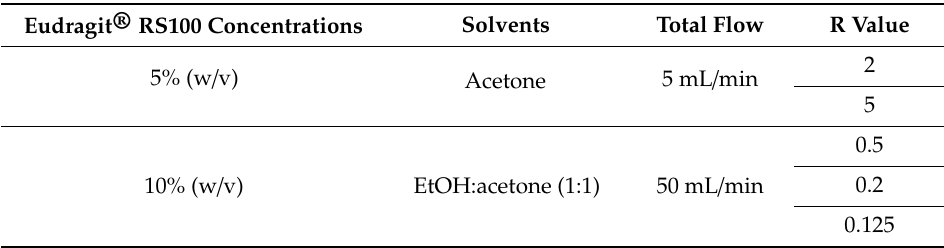
Table 2. Parameters and conditions used for the Eudragit ® RS100 nanoparticle synthesis by microfluidic nanoprecipitation.